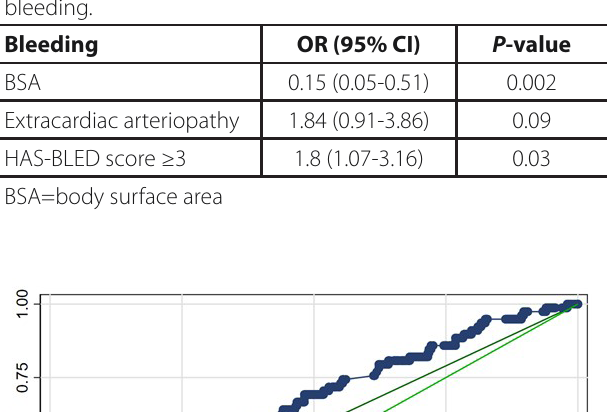
Fig. 2 - Receiver operating characteristic curve for bleeding and HAS-BLED categories with the original renal impairment definition (model 1) and the renal impairment definition based on creatinine clearance (model 2).